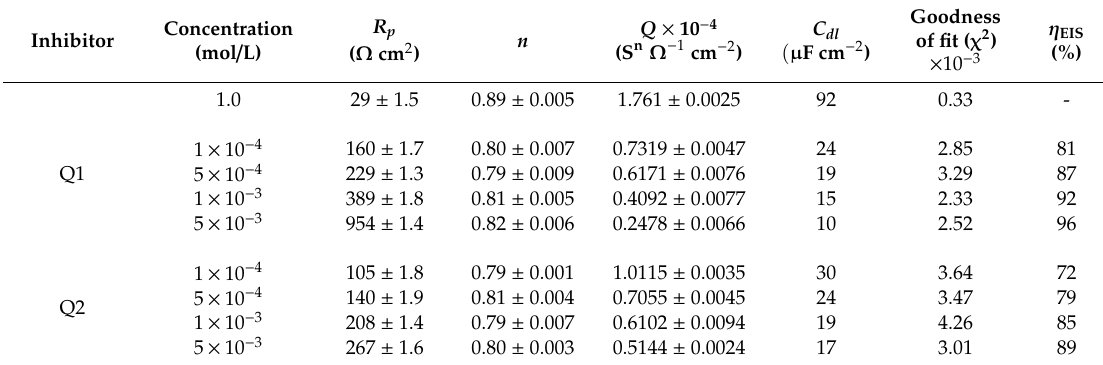
Table 2. Impedance parameters and inhibition e ffi ciency values for MS in HCl medium in uninhibited and inhibited solutions at 303